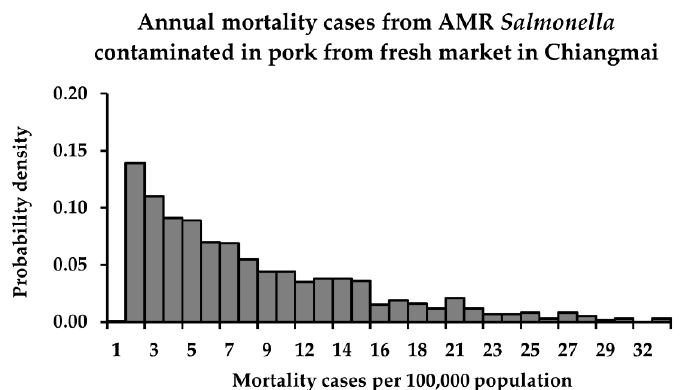
Figure 1. Annual mortality cases from susceptible Salmonella -contaminated pork from the fresh market in Chiang Mai.